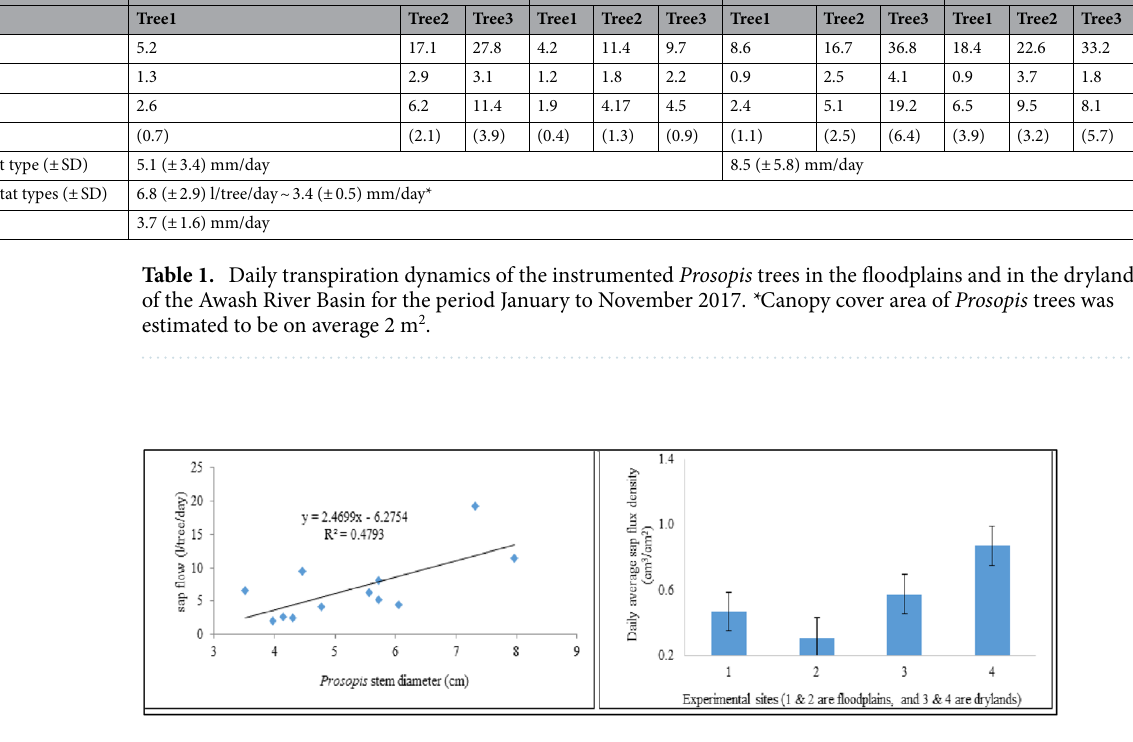
Figure 4. Relationship between sap flow and stem diameter of the sampled Prosopis trees (left) and sap flux density per habitat types - floodplains and drylands